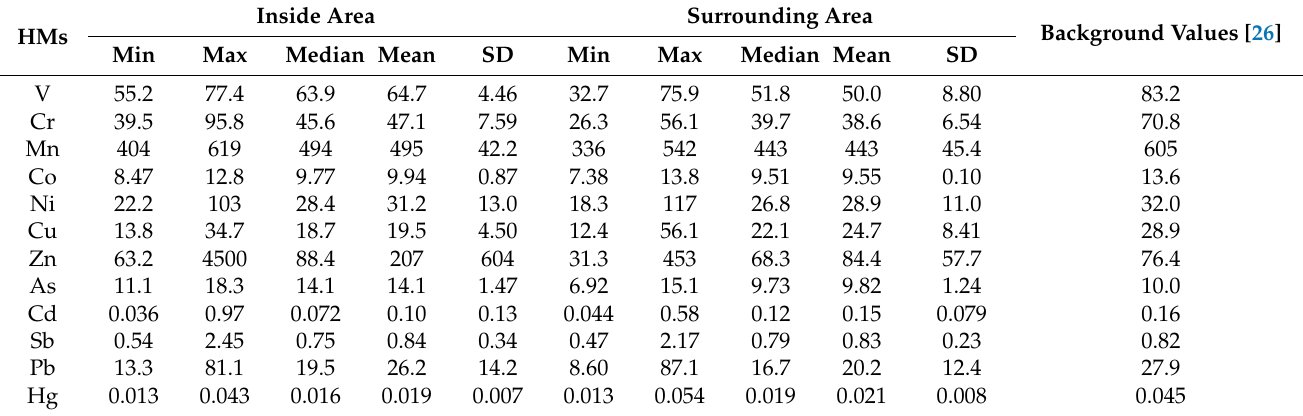
Table 1. Descriptive statistics of HM contents (mg/kg) in soils inside ( n = 53) and around ( n = 93) the petrochemical